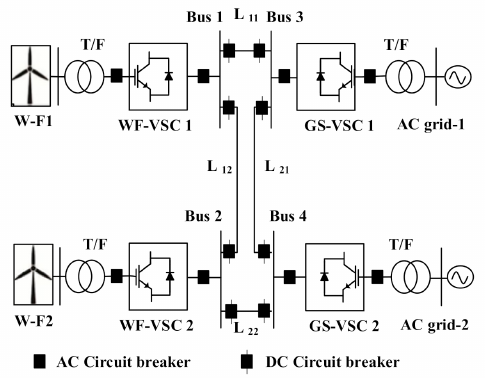
Figure 1. Four terminal Voltage-Source Converters-based (VSCs), Multiterminal High Voltage Direct- Current (MT-HVDC) transmission network, contains two on-shore AC-grids and two